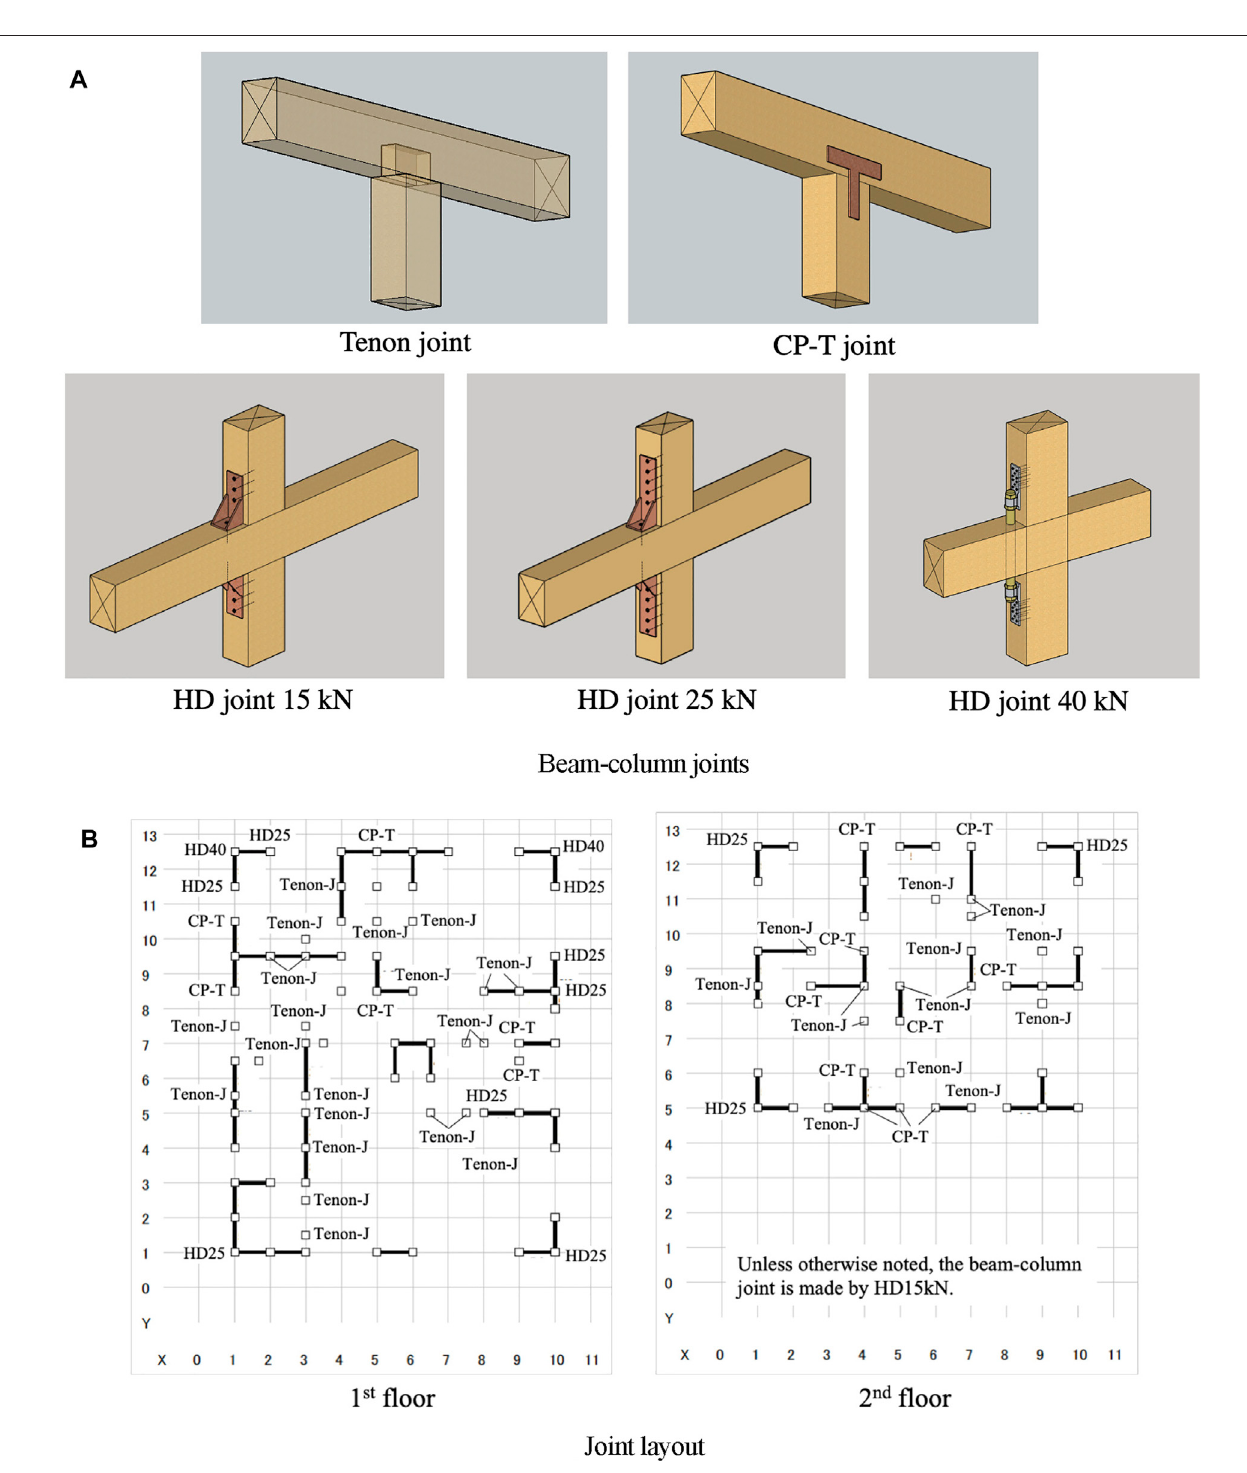
FIGURE 7 | Joints of timber frame house. (A) Beam-column joints. (B) Joint layout.